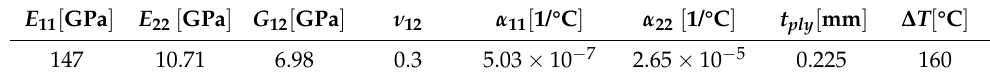
Table 1. The properties of (0/90) laminate [41].